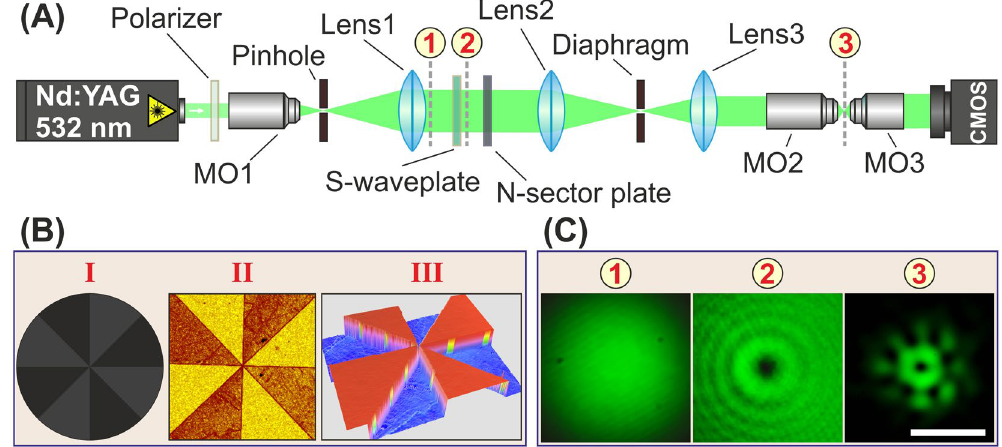
Figure 6. Experimental investigation of polarisation transformation. ( A ) Experimental setup utilised for generation of higher-order CVBs. ( B ) Example of the utilised 8-sector phase plate: (I) designed phase profile with ϕ 2 − ϕ 1 = π /2, (II) optical microscopy and (III) optical profilometry image of the central part of the manufactured element. ( C ) Beam intensity distributions measured in different planes of the experimental setup. The scale bar is 500 μ